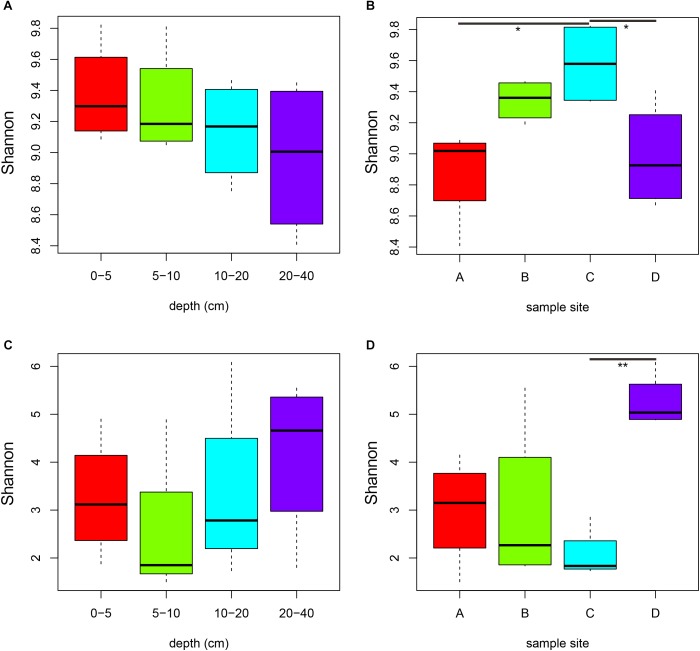
Comparisons of bacterial (A,B) and fungal (C,D) Shannon diversity indexes among soil depths (A,C) and among sites (B,D). Significance: ∗P < 0.05, ∗∗P < 0.01.